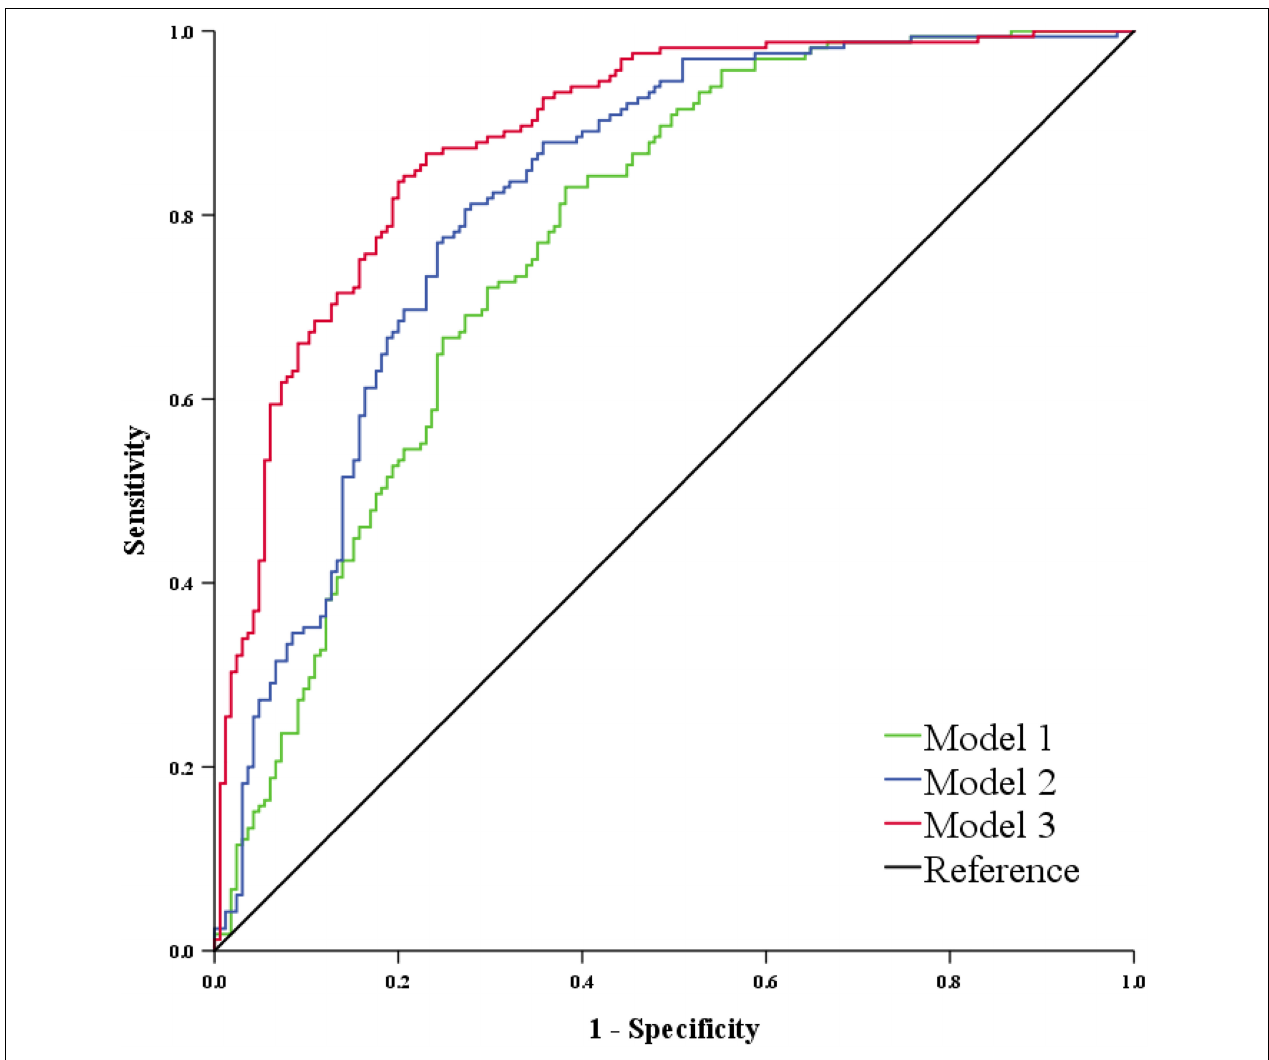
FIGURE 5 | ROC curve analysis in regard to the binary logistic regression model for the prediction of VCI. Model 1 consists of GP1, GP6, GP8, GP13, GP14, GP22, and GP23. Model 2 consists of TNF- α , IL-6, and IL-10. Model 3 consists of Model 1 and Model 2. GP, glycan peak; IL-6, interleukin-6; IL-10, interleukin-10; ROC, receiver operator characteristic; TNF- α , tumor necrosis factor-alpha; VCI, vascular cognitive impairment.